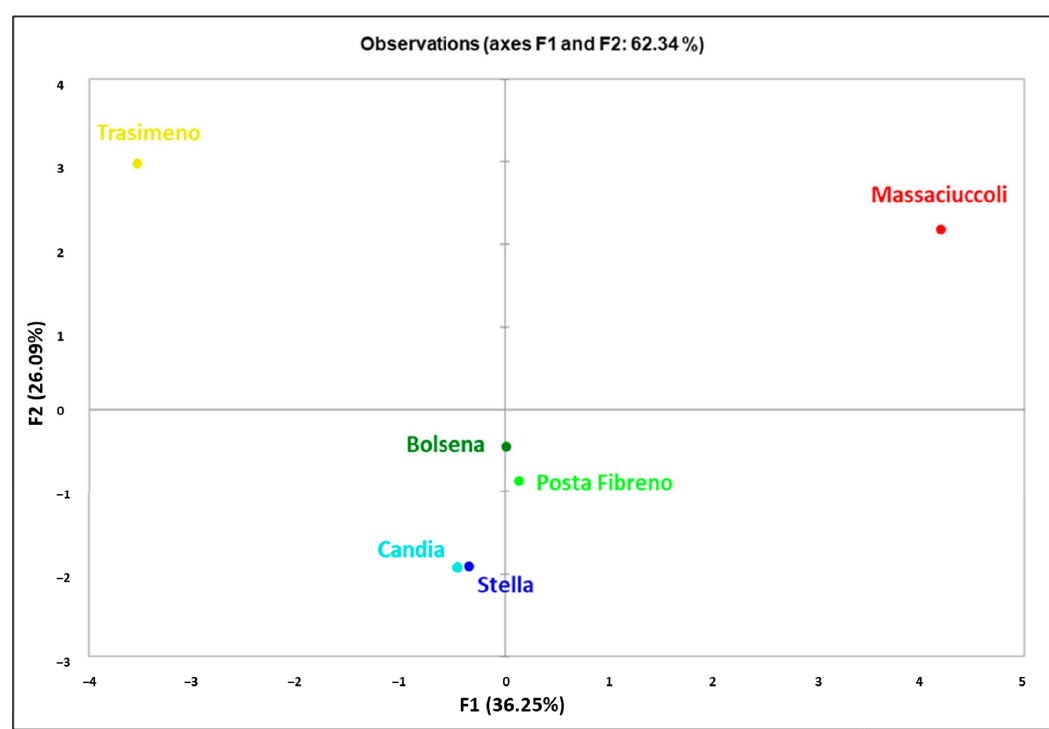
Figure 4. A two-dimensional basin-based bi-plot of concatenated mtDNA haplotype profiles (COI and CR) from the six Italian populations of P. clarkii here analyzed.